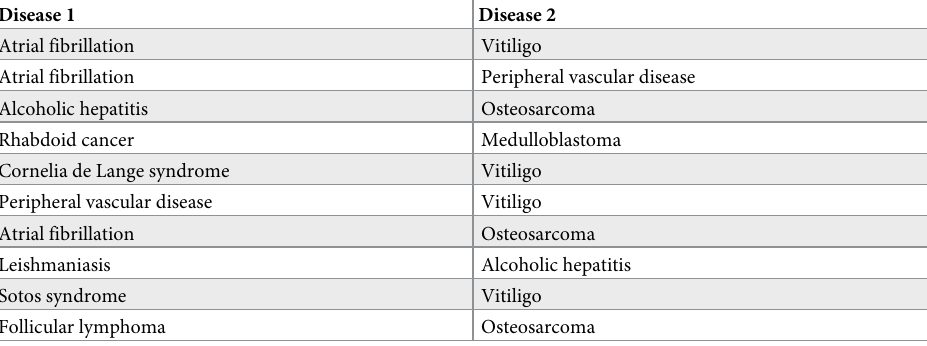
Table 6. Top 10 disease–disease links predicted using our approach based on the trained